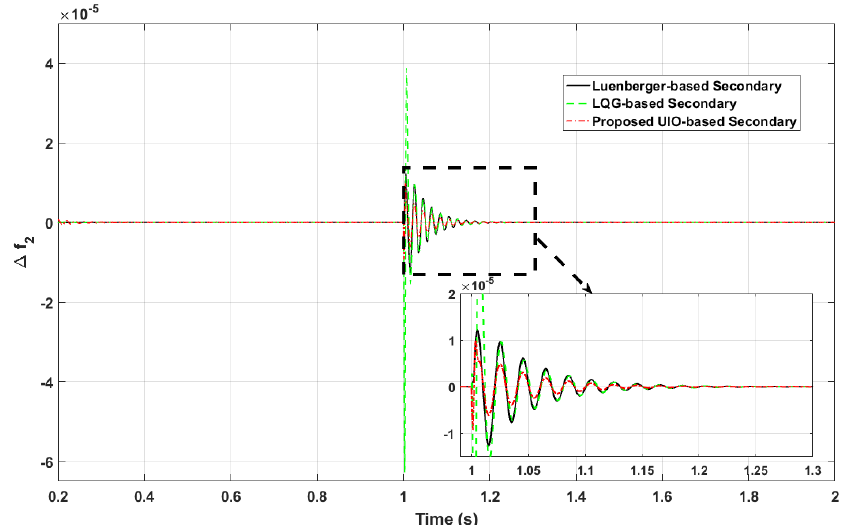
Figure 8. Second inverter frequency dynamic ∆ f 2 in scenario 1 (Step load change).